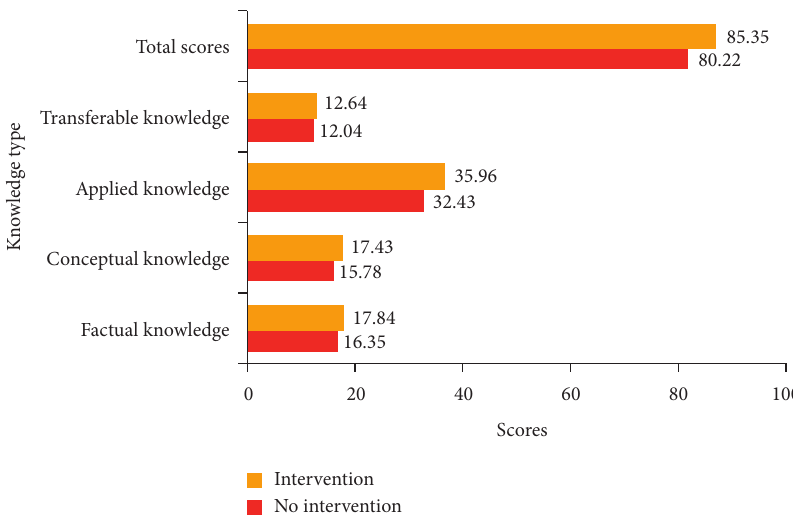
Figure 5: Unit knowledge test results without intervention and intervention.